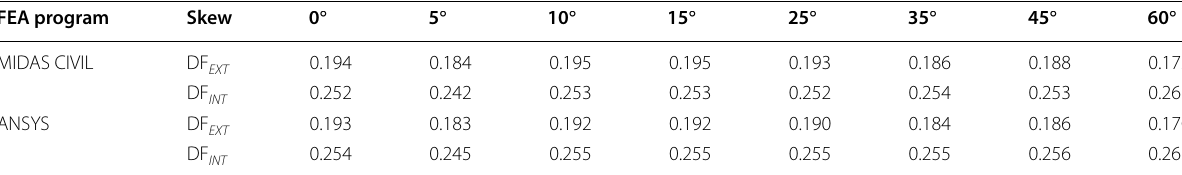
Table 5 DFs for skew parameter in the